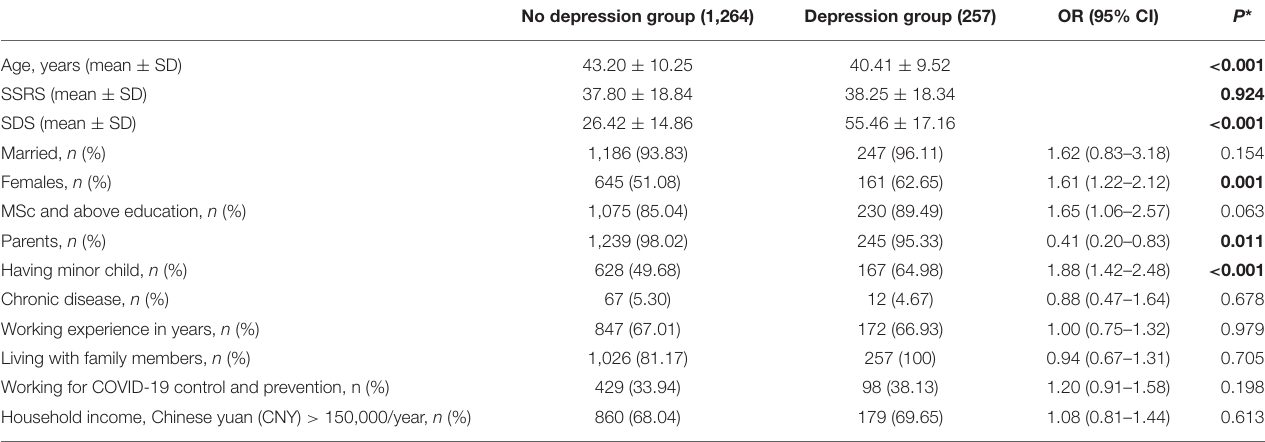
TABLE 3 | Comparison of baseline characteristics between doctors with non-depressive and depressive symptoms groups.